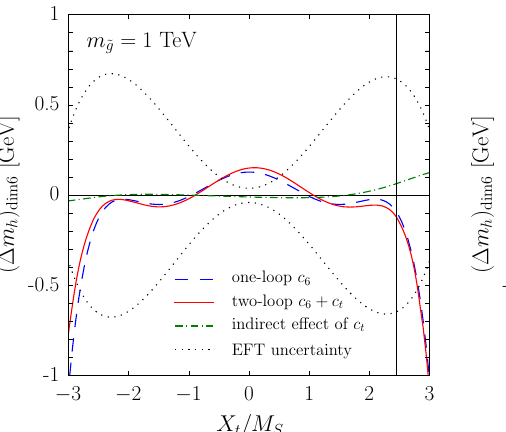
√ 6. The meaning of the different plots mark the condition X t / M S = curves and the values of the remaining MSSM parameters are the same as in Fig. 3, as described in the text